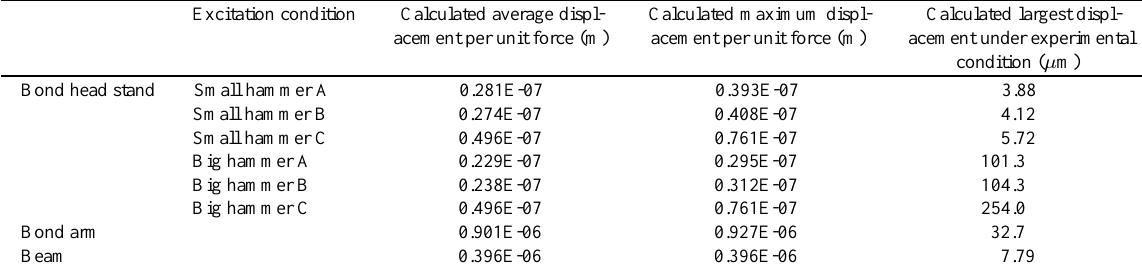
Table 3 Calculated displacements of the bond head stand, bond arm, and beam